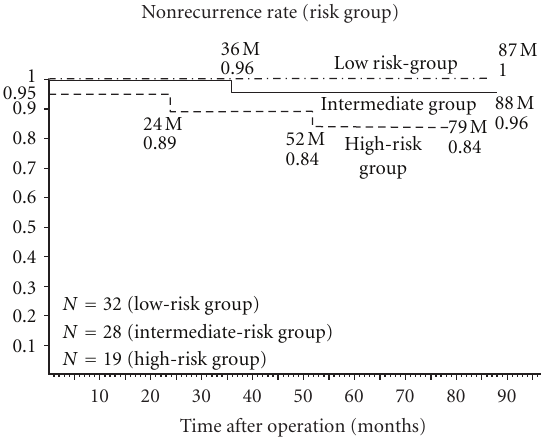
Figure 3: Actuarial biological non-recurrence rate of each risk